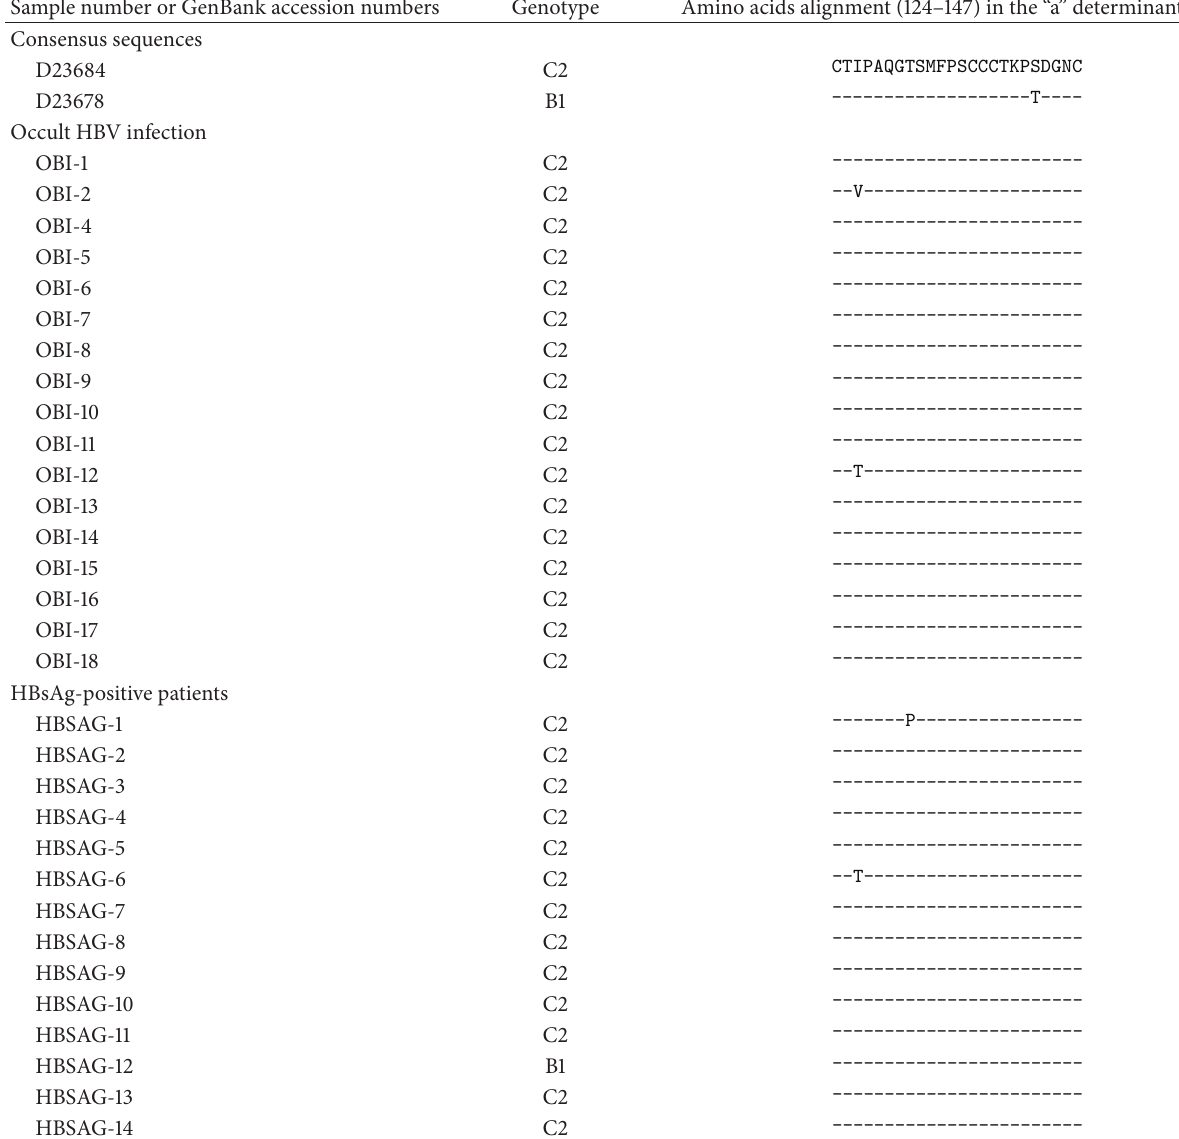
Table 4: The alignment of “a” determinant amino acid